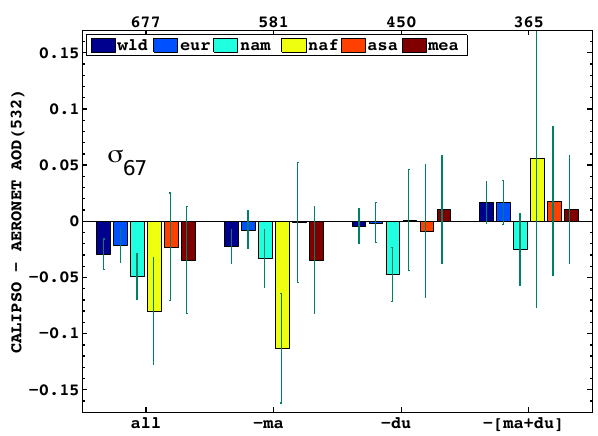
all Fig. 7. Absolute bias for all CALIPSO aerosol subtypes (all), all subtypes except marine (-ma), all subtypes except dust (-du), and all subtypes except marine and dust (-[ma + du]). The color of the bars correspond to the five regions in Fig. 5 with the largest sample sizes Fig. 7. Absolute bias for all CALIPSO aerosol subtypes (all), all and all eight regions (wld). Numbers along the top axis indicate the subtypes except marine (–ma), all subtypes except dust (–du), and total number of synchronized overpasses for all eight regions all subtypes except marine and dust (–[ma+du]). The color of the bars correspond to the five regions in Figure 5 with the largest sam- ple sizes and all eight regions (wld). Numbers along the top axis indicate the total number of synchronized overpasses for all eight regions (wld).